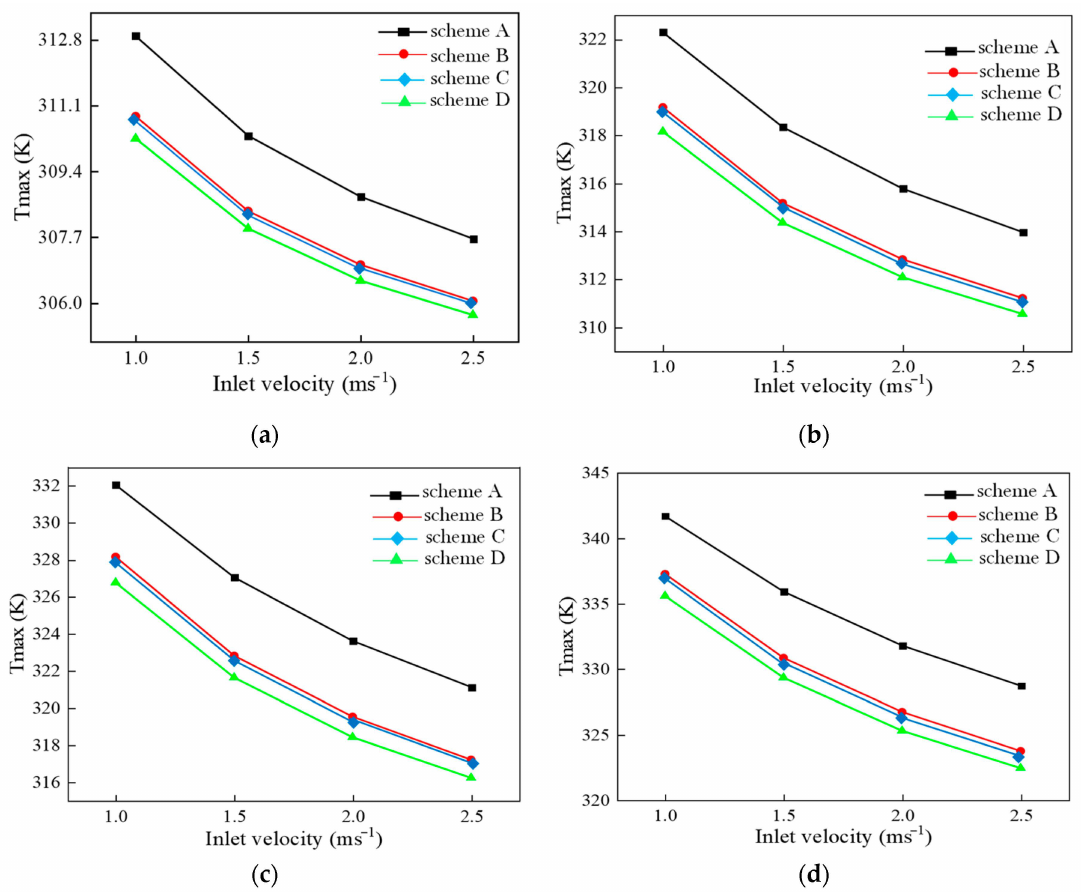
Figure 9. Variation of Tmax of scheme A, scheme B, scheme C, and scheme D with different inlet velocity. ( a ) The 2C Dr (discharge rates) discharge end; ( b ) 3C Dr discharge end; ( c ) 4C Dr discharge end; ( d ) 5C Dr discharge